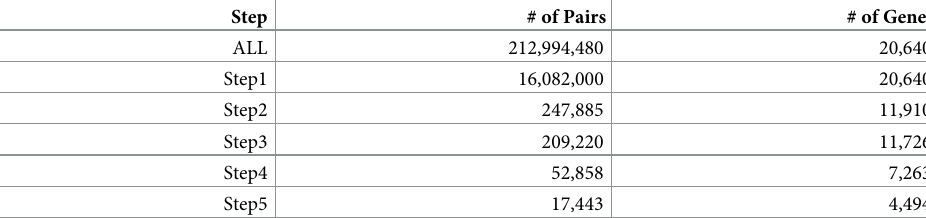
Step5 ALL: All candidate pairs after keeping proper genes with effective regulation; Step1: pairs with a significant overlap for common miRNAs; Step2: pairs after filtered based on partial correlation between gene expressions excluding copy number aberration effect; Step3: pairs after filtered based on collective regulation; Step4: pairs after applying random sampling for Step2 and Step3; Step5: pairs after applying the network deconvolution method to exclude the spurious ceRNA